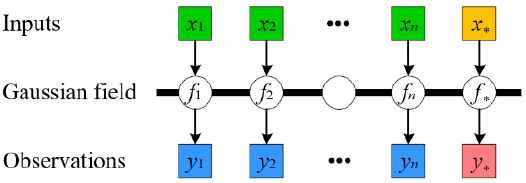
Figure 2. Graphical model for Gaussian process regression (GPR).